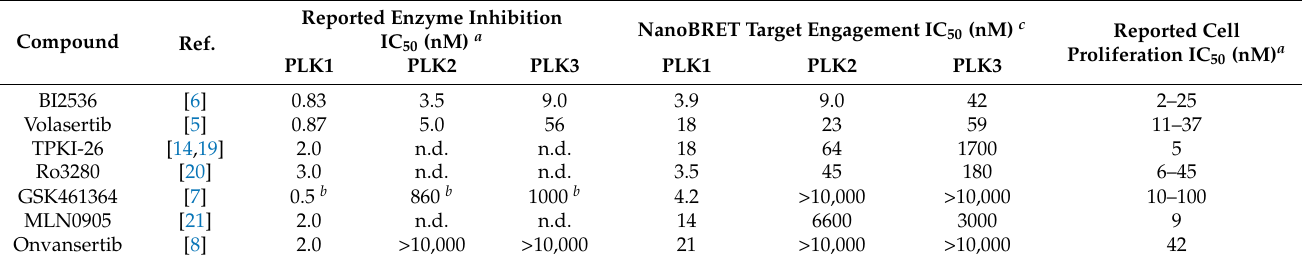
Table 1. Intracellular target engagement potency of known PLK inhibitors.